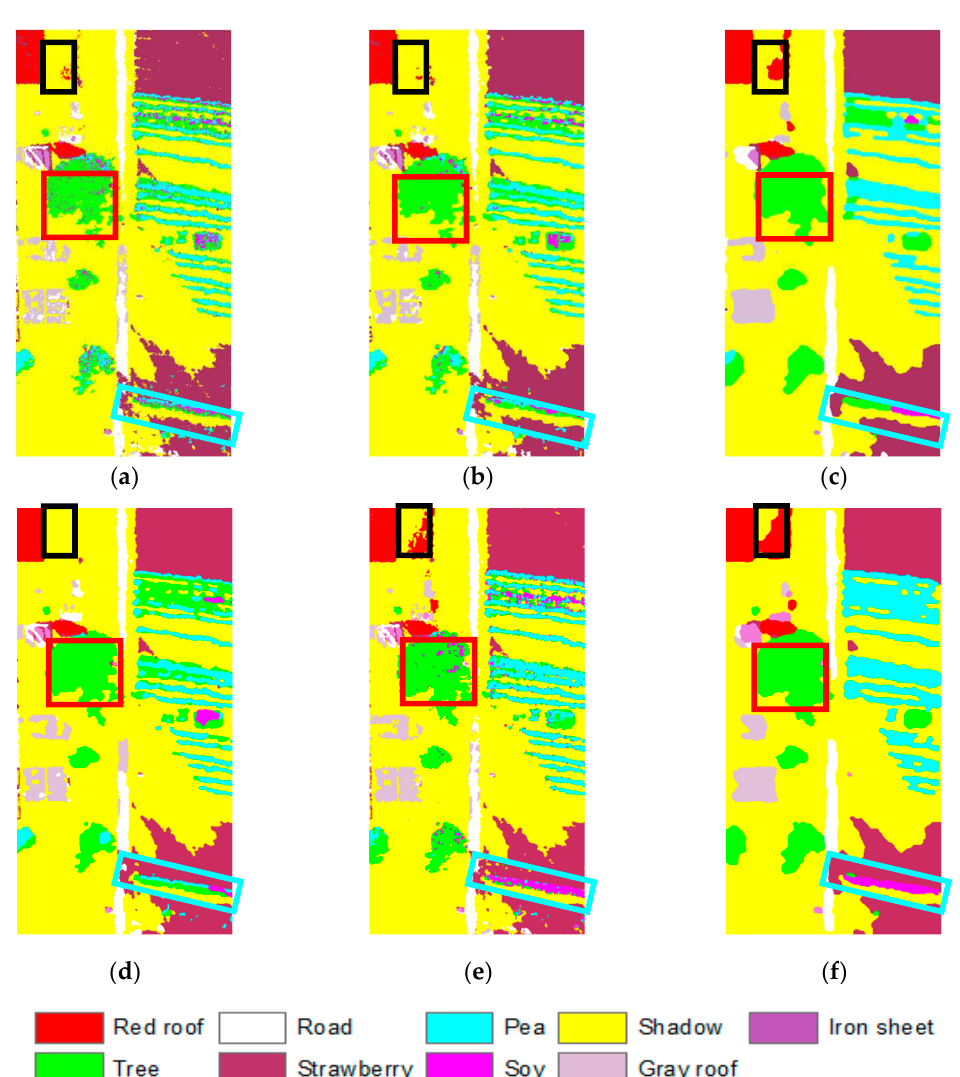
Figure 8. Hanchuan dataset classification results: ( a ) support vector machine (SVM); ( b ) mean shift segmentation (MS); ( c ) support vector conditional random field classifier with a Mahalanobis distance boundary constraint (SVRFMC); ( d ) detail-preserving smoothing classifier based on conditional random fields (DPSCRF); ( e ) Markovian support vector classifier (MSVC); ( f ) spatial-spectral fusion based on conditional random fields (SSF-CRF). Table 2. The confusion matrix of SSF-CRF for the Hanchuan dataset (%).